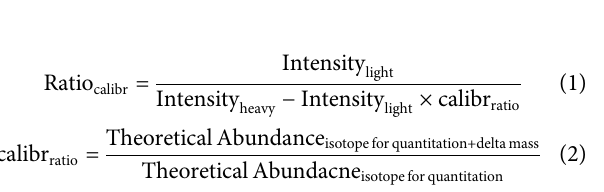
FIGURE 1 | General pipeline of gQuant for MS-based glycan quantitation using stable isotope